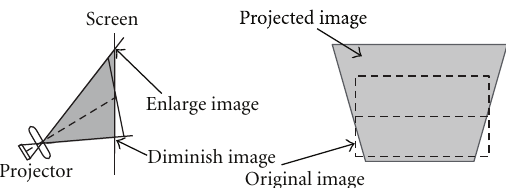
Figure 9: Image projected at a tilt on side wall.